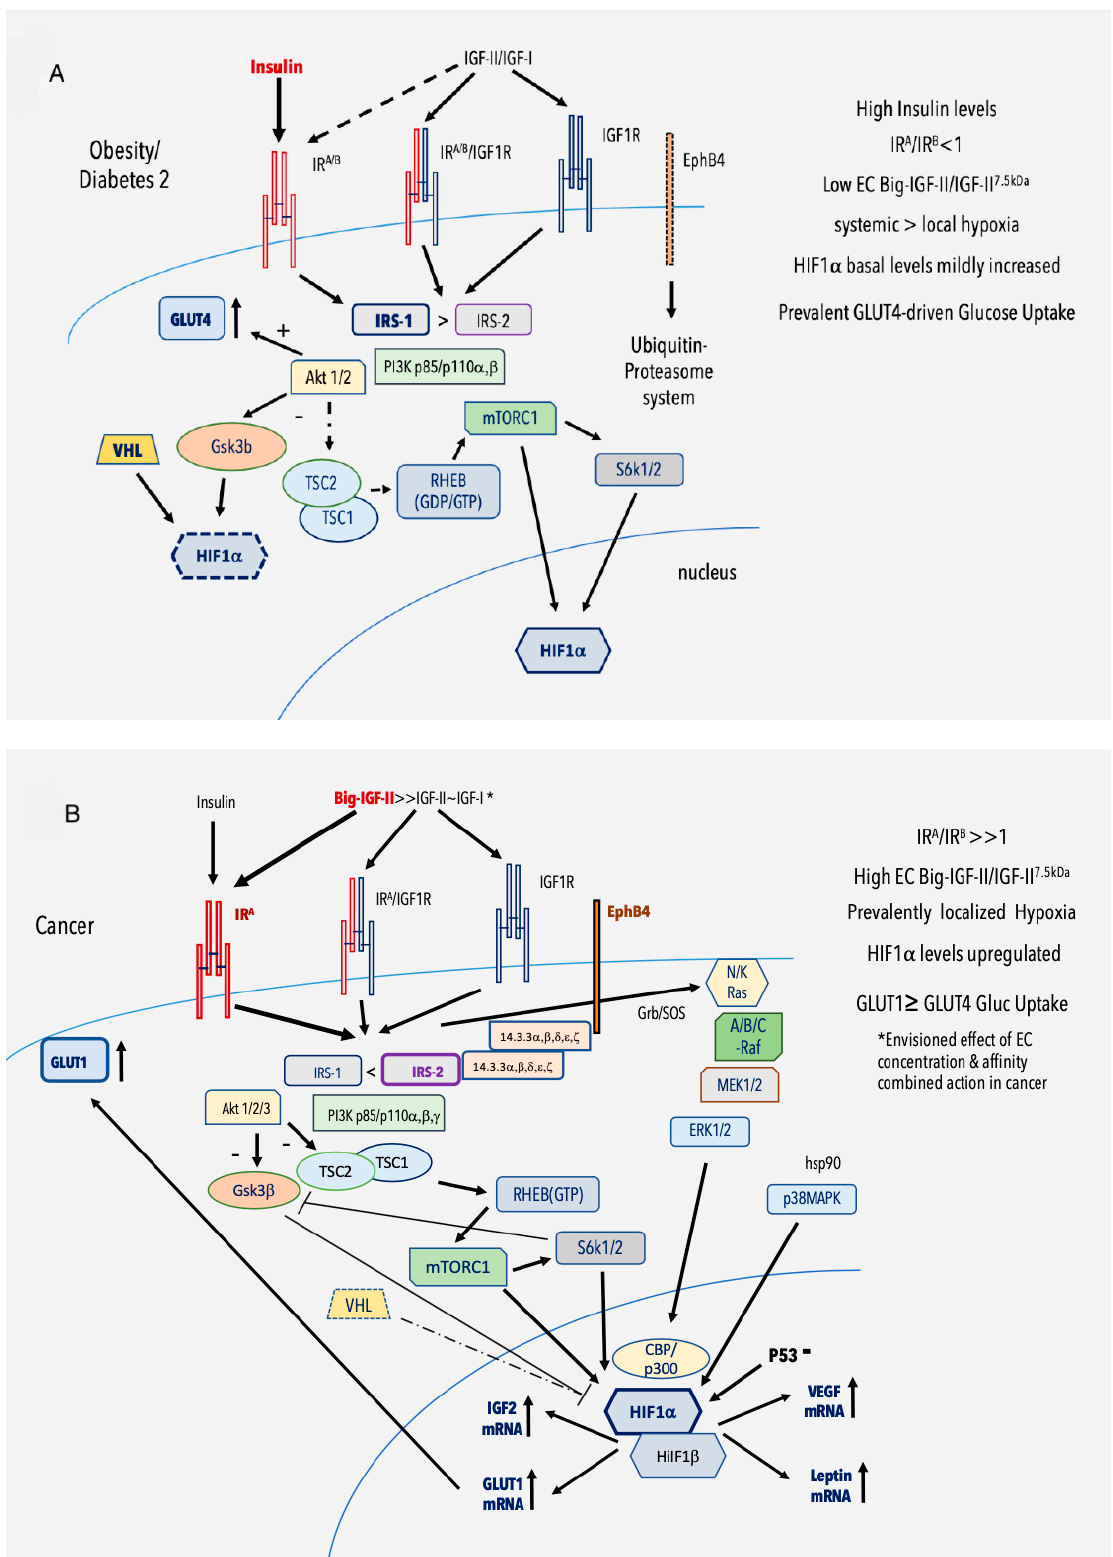
Figure 2. Working model for the regulation of Hypoxia-Inducible Factor (HIF)-1 by the IGF / IR system under insulin-resistant-associated conditions ( A ) and in cancer ( B ). ( A ) E ff ects of generalized and chronic hypoxic stimuli on HIF1 α cellular content by the IR / IGF signals (such as under insulin-resistant -associated conditions). ( B ) E ff ects of marked and localized hypoxic stimuli on HIF1 α by the IGF / IR system and signaling (such as in malignancy). Explanation in the